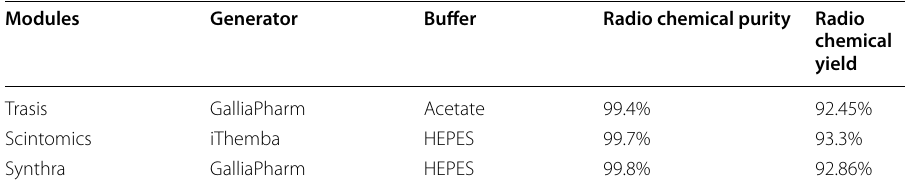
Legend: Syntheses conducted using the cassette and chemistry kit for labeling PSMA‑11 with. 68 Ga at 90 °C and 4 min with 300 µg Ascorbic acid added to the buffer system (n =